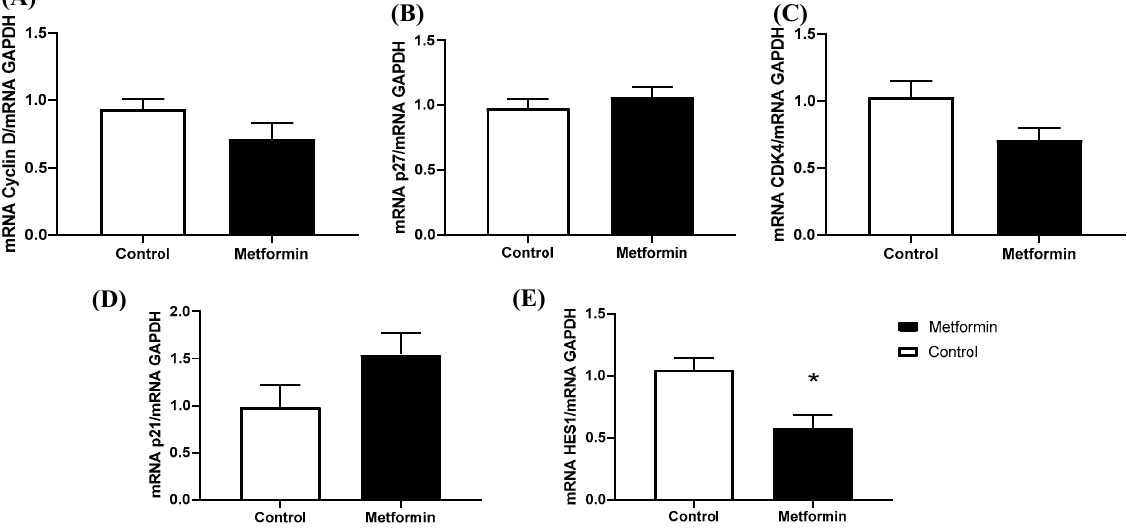
Figure 2. Gene expression in Lewis lung carcinoma cells treated with 10 mM metformin. ( A ) mRNA Cyclin D/GAPDH; ( B ) mRNA cyclin dependent kinase inhibitor (p27)/GAPDH; ( C ) Cyclin dependent kinase 4 (CDK4)/GAPDH; ( D ) mRNA cyclin dependent kinase inhibitor (p21)/GAPDH; ( E ) mRNA hairy and enhancer of split 1 (HES1)/GAPDH. mRNA expression in LL/2 cells treated with or without 10 mM metformin. Data were analyzed using an unpaired t -test. * p = 0.01 vs. Control (n = 5). Data are mean ±